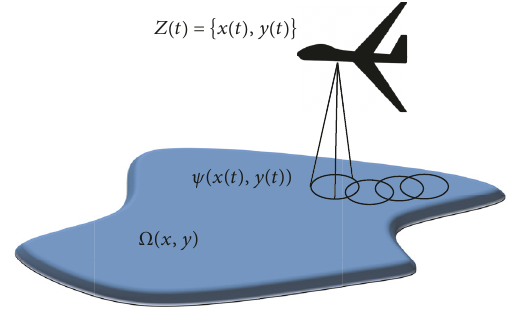
Figure 2: Area covered by sensor footprint for generated trajectory throughout the